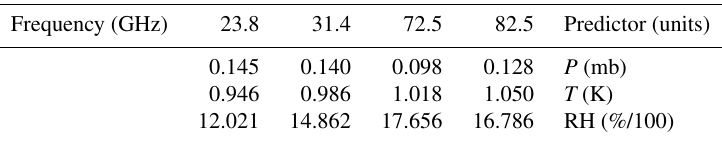
Table A1. D for multivariate multiple linear regression Eqs. (A1)–(A2) to estimate T MR from PTU only. The first row and column respectively indicate the corresponding frequency channel and predictor.